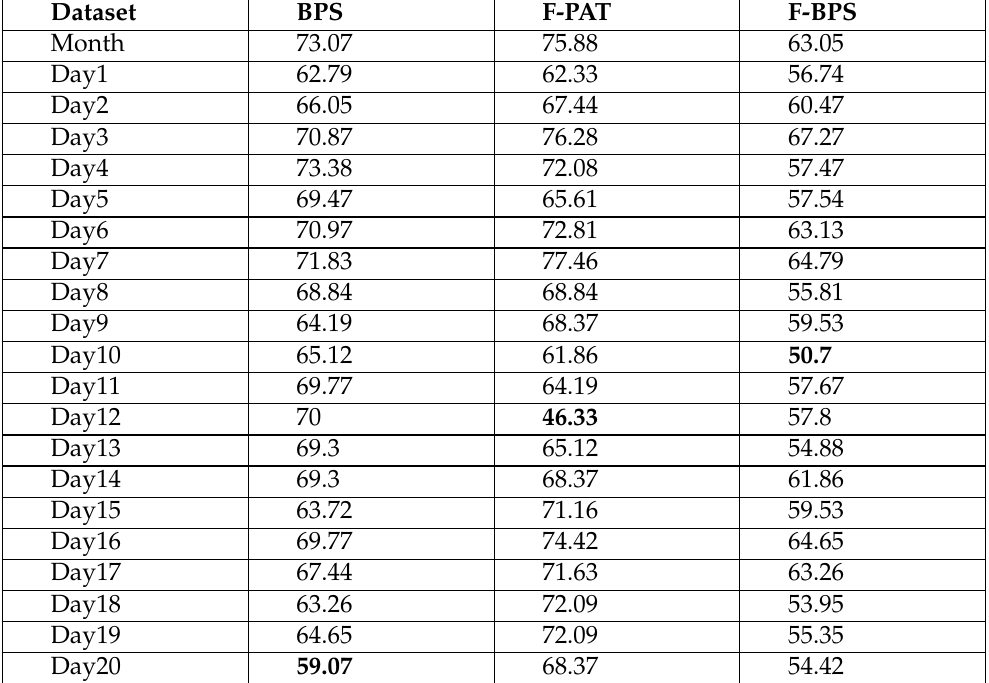
Table 3. Accuracy in % for the BPS, F-PAT, and F-BPS classifiers.